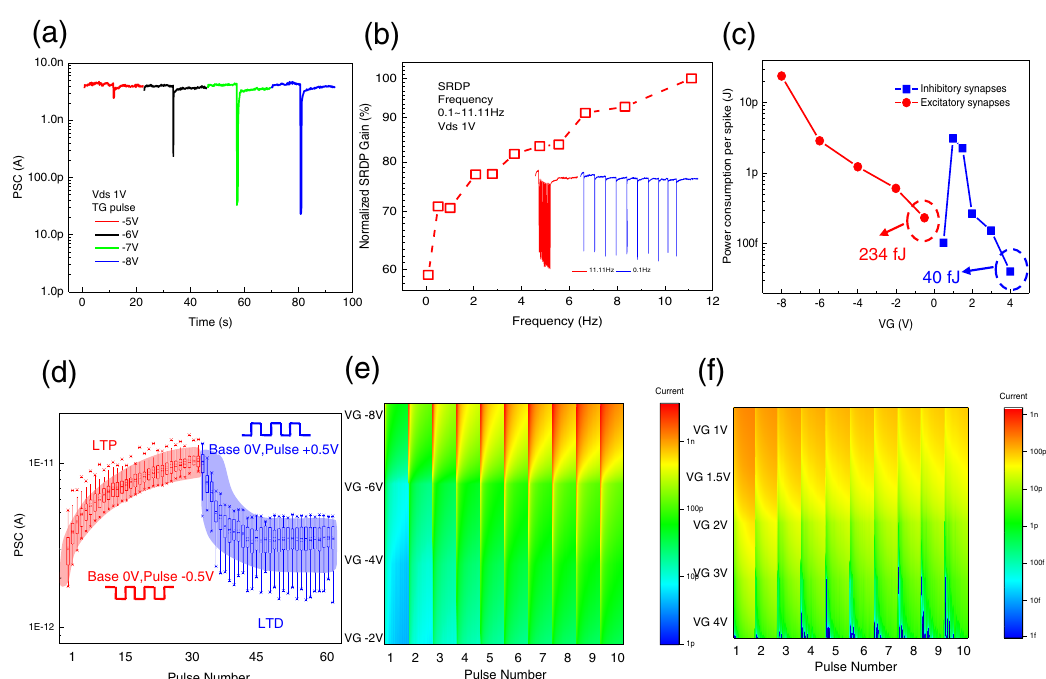
Fig. 4 Neural computation of 2D α -In 2 Se 3 FeCTs, including properties available for spiking and arti fi cial neural networks. a Under short negative spikes ( − 8 ~ − 5 V with TG step of 1 V), FeCTs exhibit incremental PSC amplitude, which strengthens with the increase of the spike amplitude, and can be refreshed quickly, thus simulating a typical neural STP. b SRDP in FeCTs neural computation, where the SRDP gain is proportional to the stimulation frequency. For relatively high-frequency stimuli (11.11 Hz in the illustration), it shows a strong inhibition effect, while for relatively low-frequency spikes (0.1 Hz in the illustration), the gain is weak. c Calculated single event energy consumption of FeCTs for simulated excitatory and inhibitory synapses under varying VG stimuli. 2D FeCTs show ultra-low power consumption, including the minimum excitation/inhibition of 234/40 fJ per spike. d Progressive excitatory and inhibitory PSC modulation is realized with ultralow spike voltages ( ± 0.5 V, 30 ms), corresponding to the LTP and LTD simulation. e PSC mapping with 10 consecutive spikes with varying negative VG. Excitatory PSC was obtained under negative VG, and the current increased with amplitude and spike accumulation, showing LTP behavior. f PSC mapping of 10 consecutive varying positive VG spikes. Inhibiting PSC appears under positive spikes, and current decreases with increasing amplitude and spikes, showing LTD